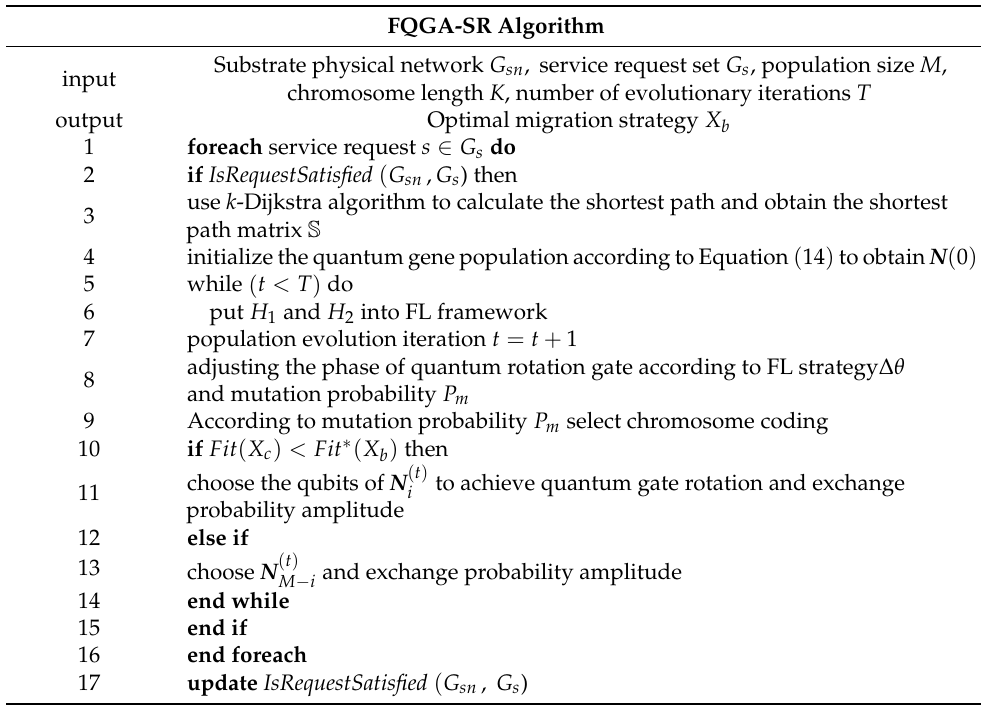
Table 2. FQGA-SR Algorithm